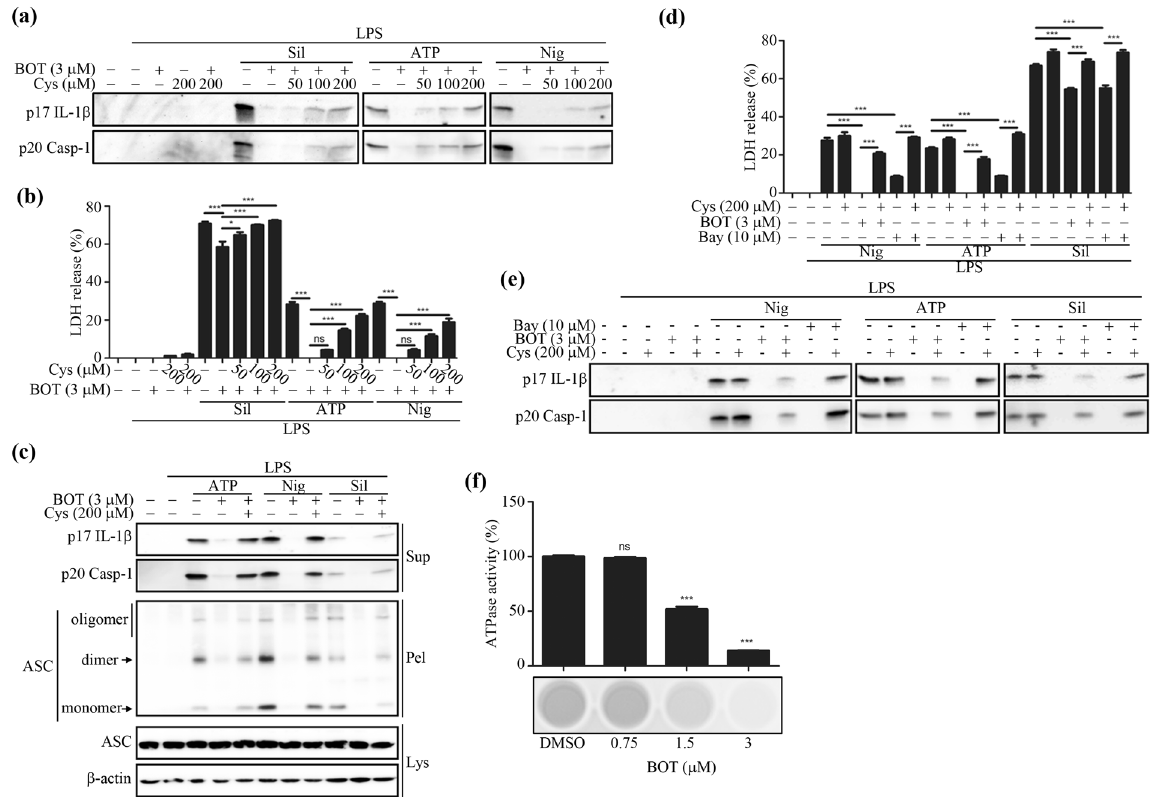
Figure 5. Involvement of BOT-4-one on the the inhibition of the ATPase activity of NLRP3 and the inhibition of NLRP3 inflammasome activation through NLRP3 alkylation. LPS-primed BMDMs were treated with BOT-4-one or Bay11-7082 (Bay) for 1 h in the presence or absence of L-cysteine (Cys) and then stimulated with nigericin (Nig), ATP, or silica crystals (Sil). ( a and e ) The supernatants were analyzed by immunoblot. Full-length blots/gels are presented in Supplementary Fig. S12a and b. ( b and d ) The LDH release in the cell supernatants was measured by LDH assay. ( c ) ASC oligomerizations in cross-linked cytosolic pellets were analyzed by immunoblot. Full-length blots/gels are presented in Supplementary Fig. 12c. ( f ) The amount of NLRP3-mediated ATP converted into ADP in the presence or absence of BOT-4-one was determined by luminescence by using the ADP-Glo assay. The data represent the mean ± SEM of three independent experiments; * p < 0.05; *** p < 0.001; ns: